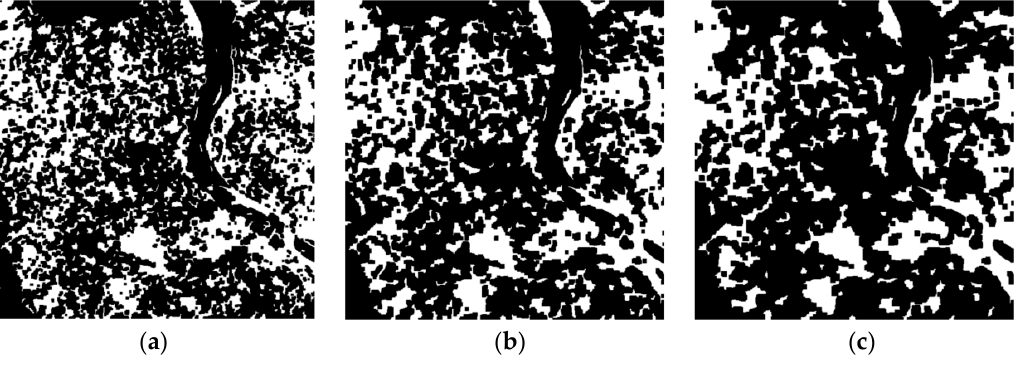
Figure 12. Image differencing results between normalized subject image generated by SR and reference image: ( a ) noise reduction using SLIC 5 × 5; ( b ) noise reduction using SLIC 7 × 7; and ( c ) noise reduction using SLIC 9 × 9.